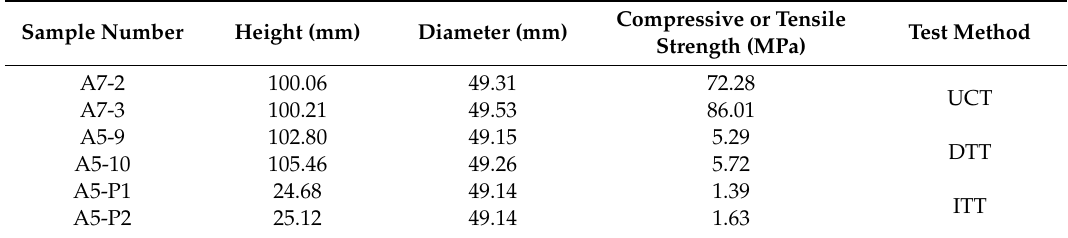
Table 1. Details of the test specimens.